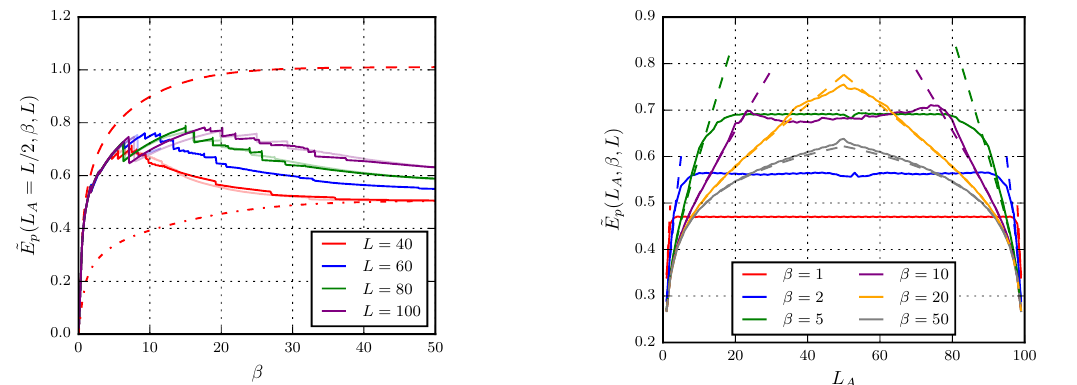
Figure 9. (a) The disentangled entropy ~ E p ( L A ; (cid:12); L ) at the middle cut calculated using our disentangling algorithm ( L A = L= 2). The calculation was done using a DMRG truncation error cuto(cid:11) (cid:15) = 10 (cid:0) 14 and maximal bond dimension (cid:31) = 48. Faded lines correspond to calculations using (cid:31) = 12, which do not show a signi(cid:12)cant di(cid:11)erence beyond the (cid:13)uctuation from the disentangling. The dashed lines are results for the TFD state without disentangling and dash-dotted lines are half the mutual information to serve as an upper and lower bound respectively for L = 40. (b) Dependence of ~ E p ( L A ; (cid:12); L ) on the subsystem size L A . Results for L = 100 are shown with solid lines. Dashed lines show the minimum thermodynamic entropy min S ( A ) ; S ( (cid:22) A ) of the two f g subsystems subsystem, which matches excellently with ~ E p up until saturation, as predicted from the holographic